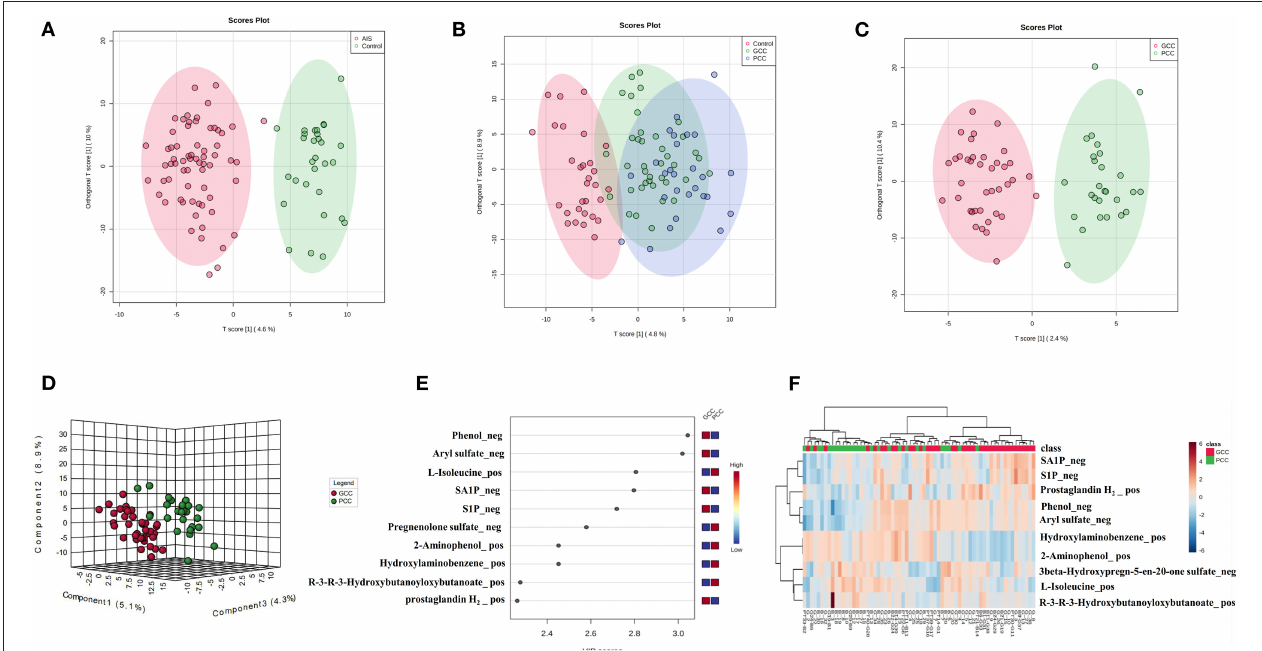
FIGURE 2 | Metabolic profile of patients with GCC compared with patients with PCC. (A) OPLS-DA two-dimensional plot ellipses representing 95% CIs between AIS and healthy control groups. (B) OPLS-DA two-dimensional plot ellipses representing 95% CIs among healthy control, PCC, and GCC groups. (C) OPLS-DA two-dimensional plot ellipses representing 95% CIs between PCC and GCC groups. (D) The three-dimensional PLS-DA plot showing good model discrimination between patients with GCC compared with patients with PCC. (E) The VIP plot generated from the PLS-DA analysis showing the top 10 discriminative metabolites when the GCC group compared with the PCC group. (F) The heat map of the top 10 differentially accumulated metabolites when GCC group compared with PCC group. AIS, acute ischemic stroke; GCC, good collateral circulation; PCC, poor collateral circulation; OPLS-DA, orthogonal partial least squares discriminant analysis; PLS-DA, partial least squares discriminant analysis; VIP, variable importance in